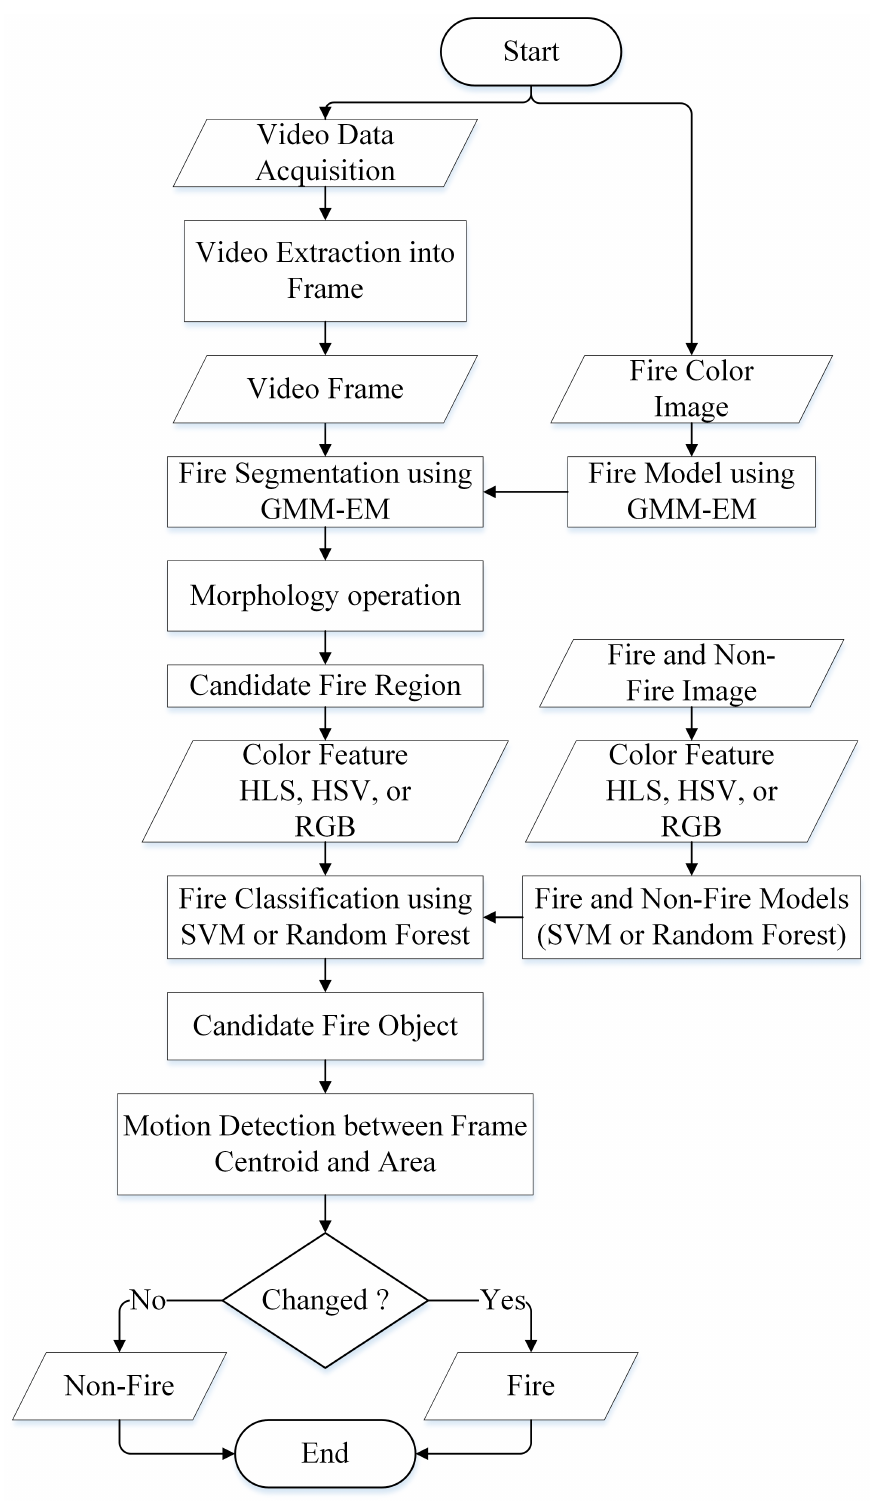
Figure 1. The proposed method